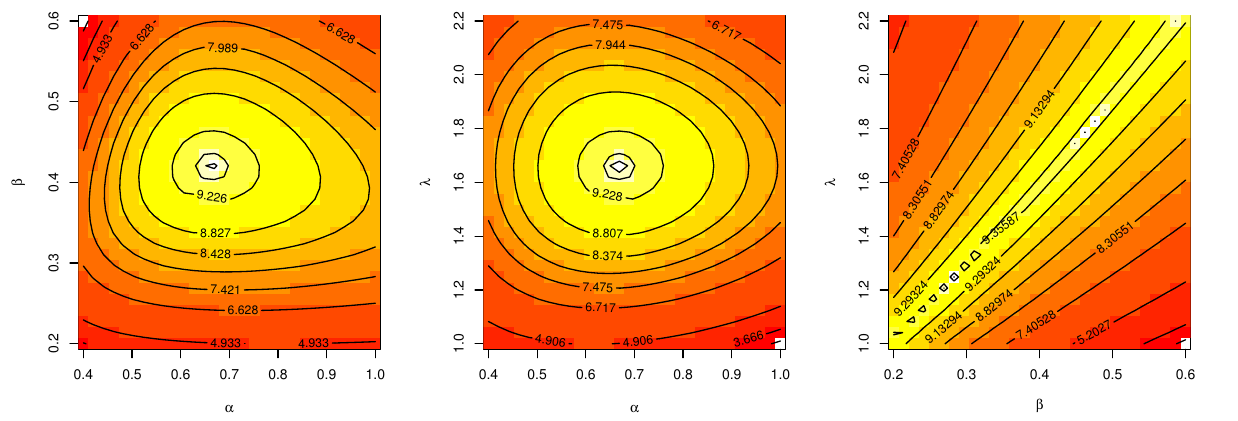
Figure 19. Profile likelihood of UEPD for France COVID-19 data.